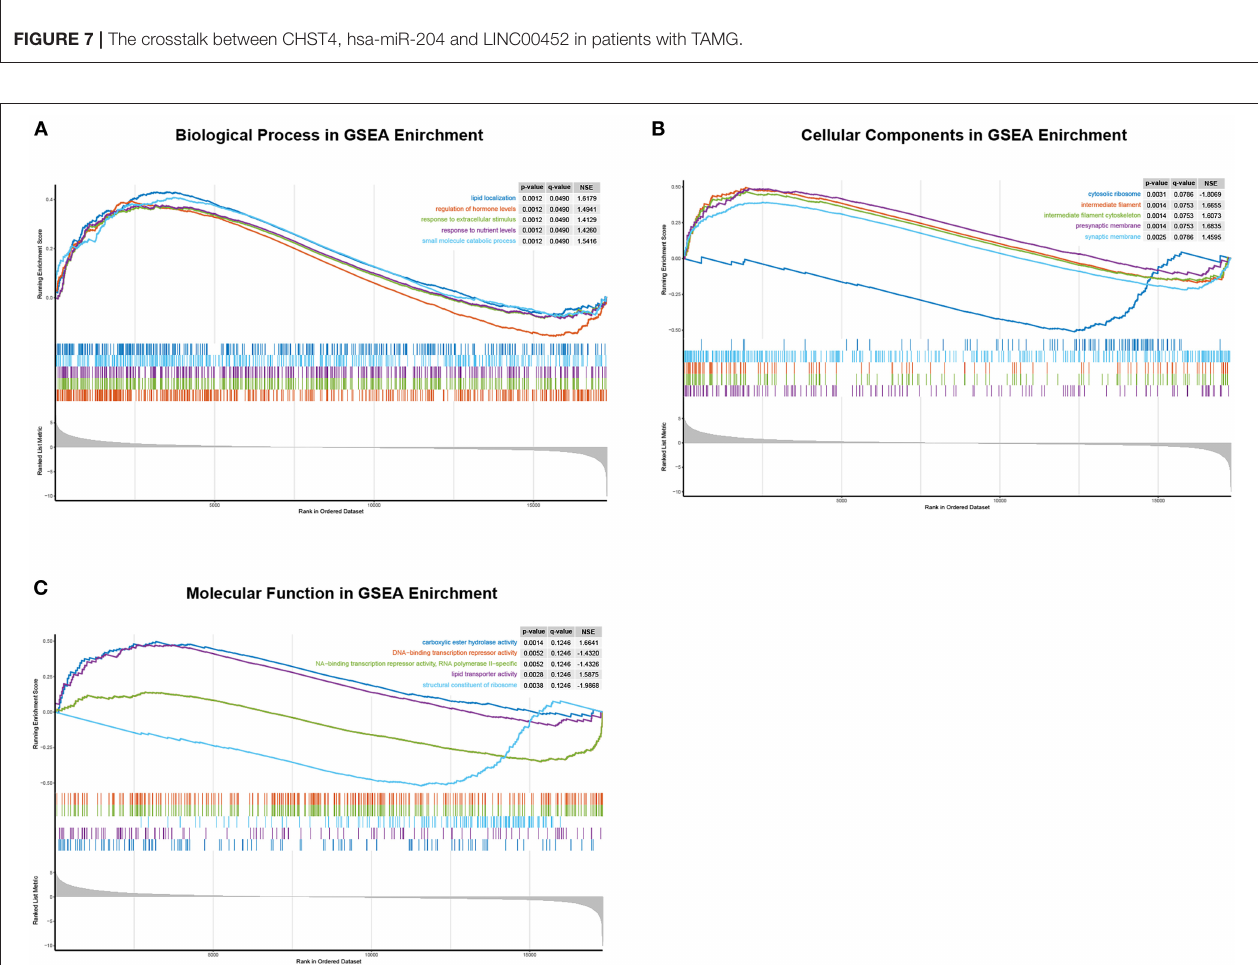
FIGURE 8 | GO enrichment analysis of differentially expressed genes between the high- and low-CHST4 expression groups in TAMG patients using GSEA. (A) The biological process in GSEA; (B) The cellular components in GSEA; (C) The molecular function in GSEA; In (C) , the curve representing “DNA-binding transcription repressor activity” was covered by that representing “DNA-binding transcription repressor activity, RNA polymerase II-specific”; these two curves are of similar